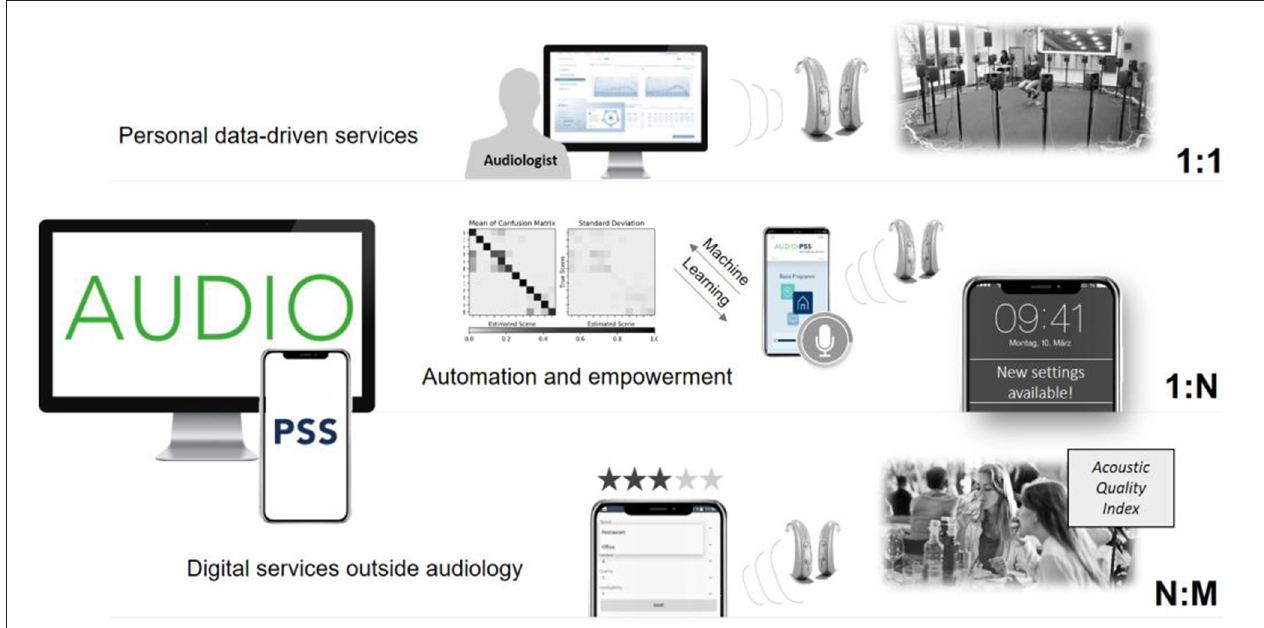
FIGURE 1 | Overview of the Audio-PSS platform